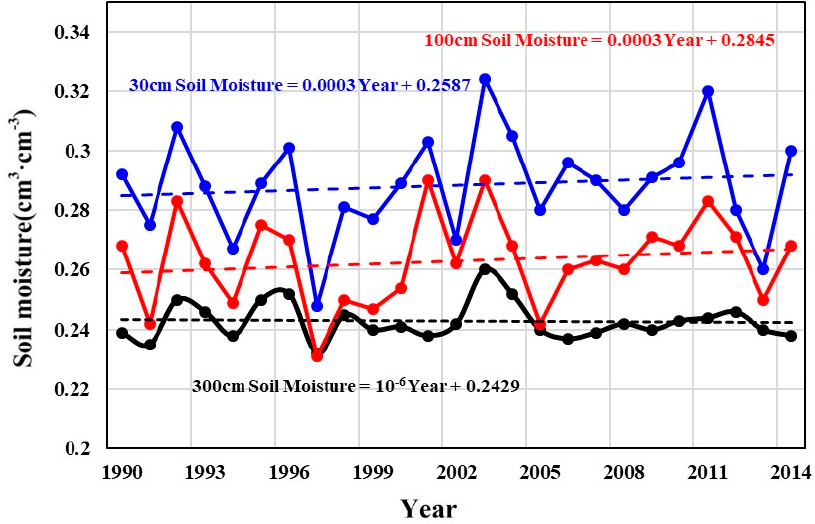
Figure 9. The temporal changing trend of soil water content in different soil depths of the Loess